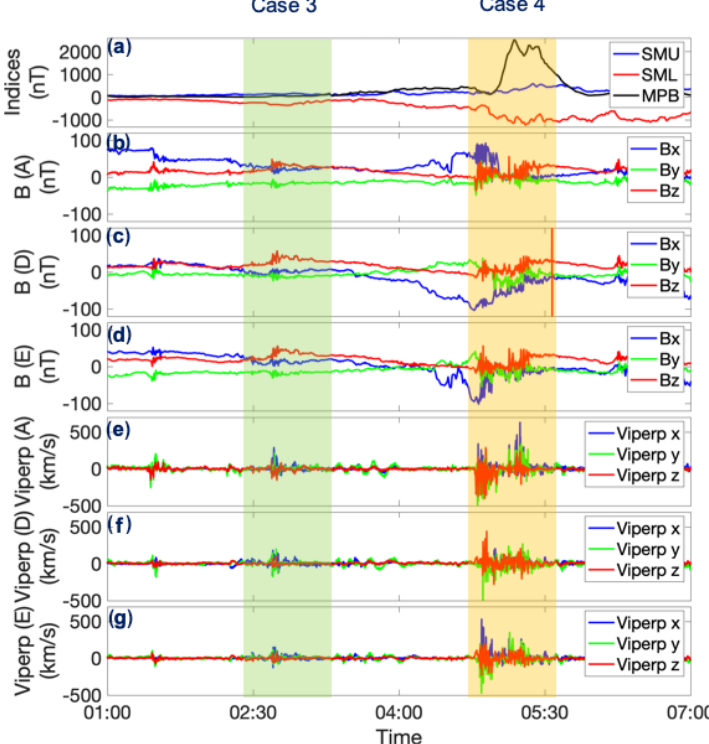
Figure 2. THEMIS spacecraft in situ measurements for fast flow burst Cases 3 and 4 that were observed on 20 December 2015. The caption of Fig. 1